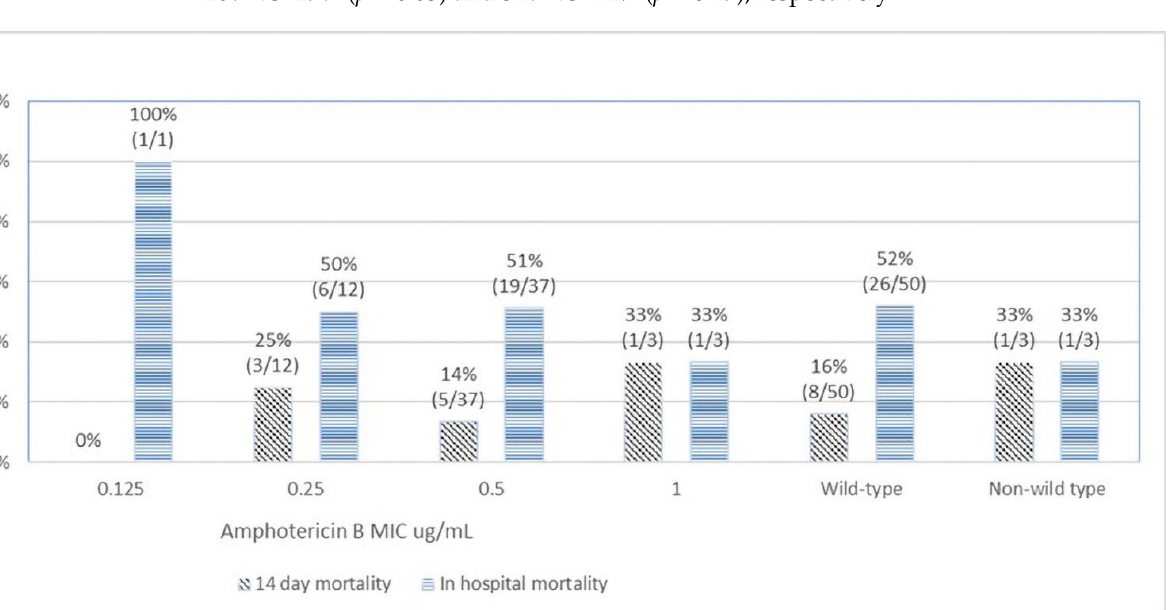
Figure 2. Correlation of fluconazole minimal inhibitory concentration with 14-day and in-hospital mortality. 3.4. Poor Prognostic Factors for 14-Day Mortality On univariate analysis (Table 3), CSF glucose level <5 mg/dL (11.3% vs 55.6%, p = 0.008), higher CSF cryptococcal antigen burden (10 vs 12, p = 0.002), and higher serum cryptococcal antigen burden (9 vs 12, p = 0.007) were found to contribute to 14-day mor- tality (Table 3). Disease severity, as assessed by SOFA score (1.5 vs 3, p = 0.13) or GCS score (15 vs 13, p = 0.43), and delayed amphotericin B induction (6.8% vs 0%, p = 0.42) were not found to have contributed to the prognosis of initial 2-week therapy.